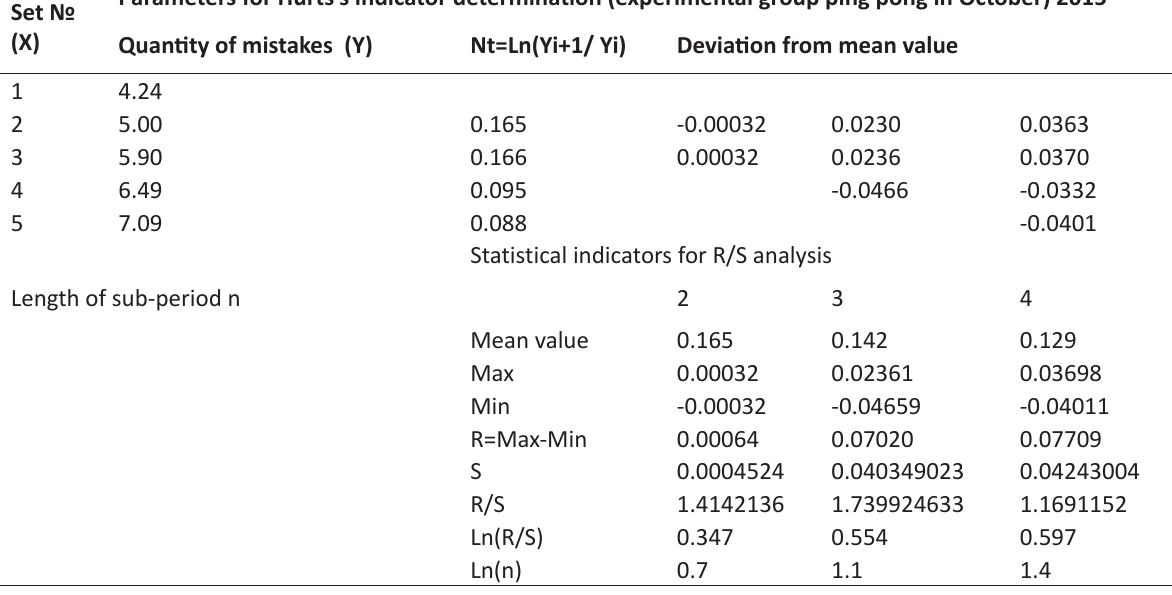
Table 1. Parameters for Hurst’s indicator determination ( experimental group ping pong in October) 2015 Set №